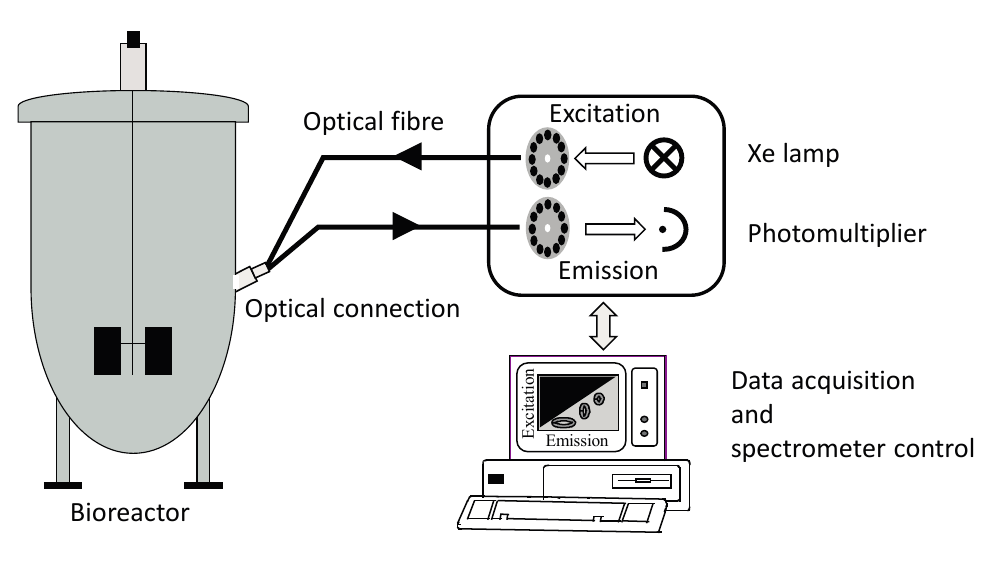
Figure 3. Overview of the BioView ® set